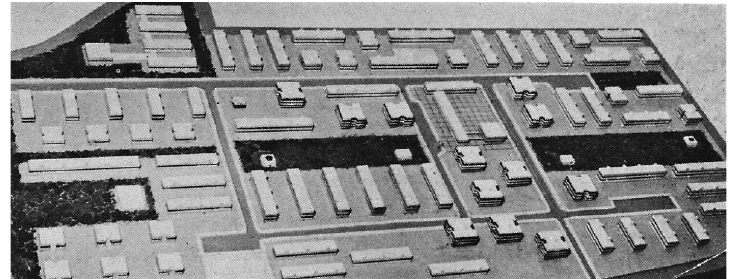
Figure 3. Model of neighborhood construction in Netanya, combining zeilenbau and the open plan. Source: Ministry of Housing (1964).